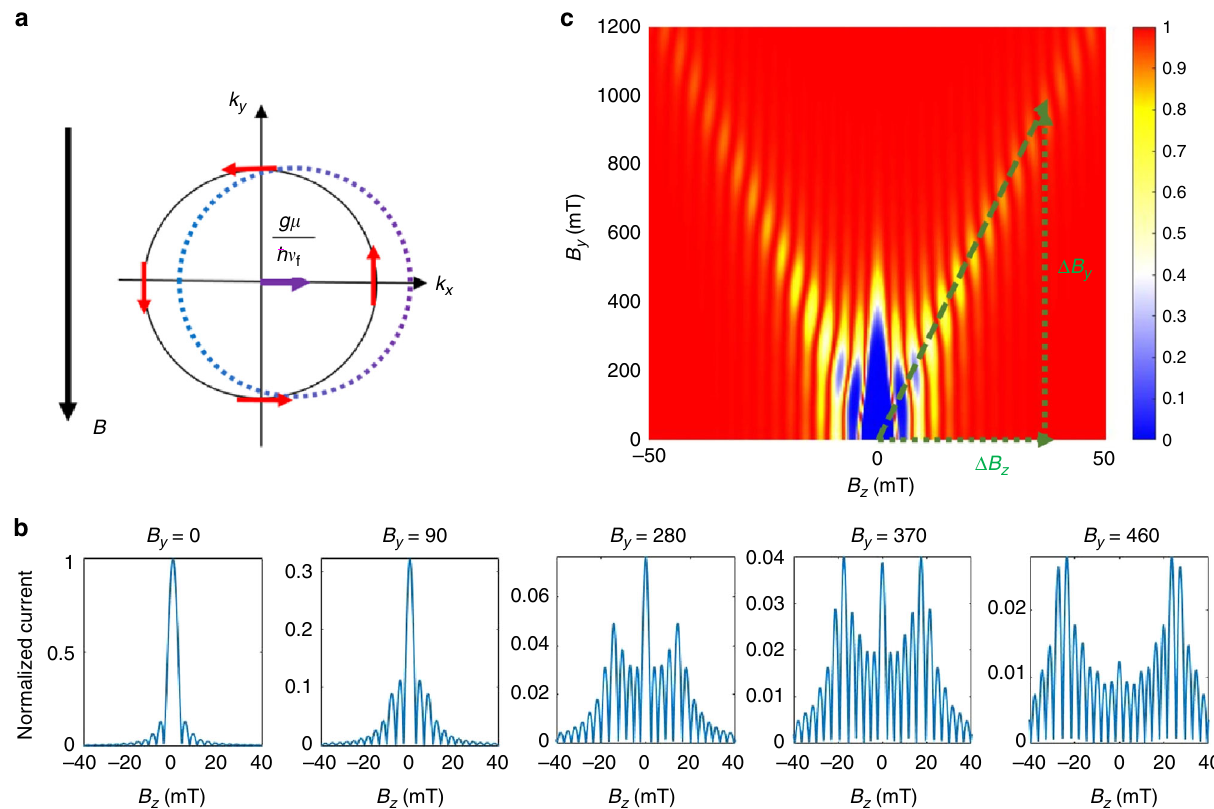
Fig. 3 Finite momentum shift and simulation of trident pattern for ideal junction. a The shifted Fermi surface and spin texture (red arrows) of the TI due to a fi nite Zeeman effect. To form a spin singlet, Cooper pairs acquire a non-zero center of momentum, as indicated by the purple arrow. b Simulations of the Fraunhofer pattern for different values of B y . We fi nd that the intensity of superconductivity is transferred outwards to higher values of B z as B y is increased. c Evolution of the Fraunhofer pattern for a symmetric Josephson junction due to fi nite momentum pairing. The differential resistance is calculated and normalized to 1. The slope of the side branch is indicated by the dashed green